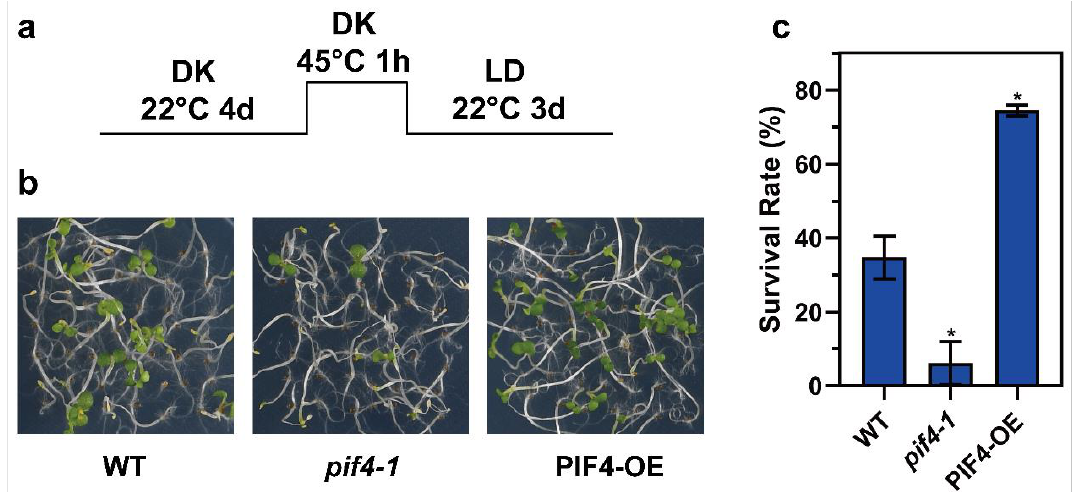
Figure 5. PIF4 overexpression enhances the thermotolerance of Arabidopsis . ( a ) Col-0, pif4-1, and PIF4-OE seedlings were grown in darkness for 4 d and then treated at 45 °C for 1 h and recovered at 22 °C for 3 d under long day conditions (16 h light/8 h darkness). ( b ) The thermotolerance phenotypes of Col-0, pif4-1, and PIF4-OE were shown after HS treatment, as indicated in ( a ). ( c ) Quantification of the survival rates indicated in ( a ). Values are the means ± SD of three independent biological replicates. Statistical differences calculated by Student’s t -test are shown. Asterisks indicate the significant differences (* p < 0.05).